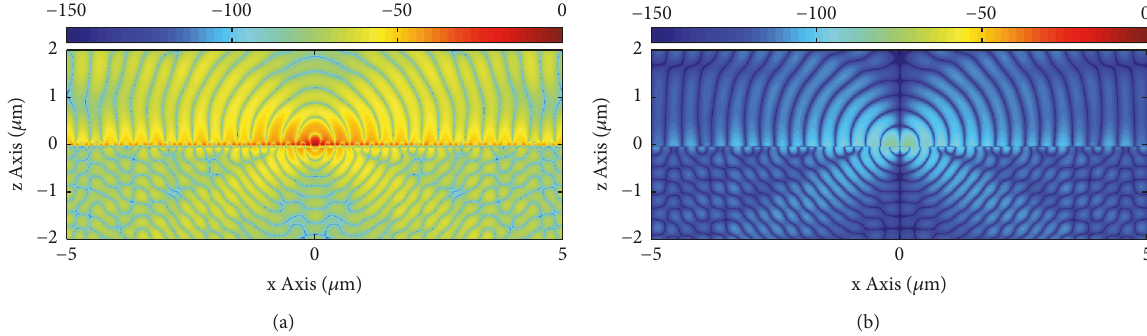
Figure 16: Electric and Magnetic Fields in the 𝑥𝑧 plane, at 𝑦 = 0 , with Δ 𝑐 = 10𝜇𝑚 : (a) 20 log | Re {𝐸 𝑧 }| ; (b) 20 log | Re {𝐻 𝑦 }| . In these results we set the following: 𝛿 𝑔 = 50𝑛𝑚 , ℎ = 20𝑛𝑚 , 𝜃 󸀠 = 𝜙 󸀠 = 0 ∘ , and 𝜆 = 632.8𝑛𝑚 .